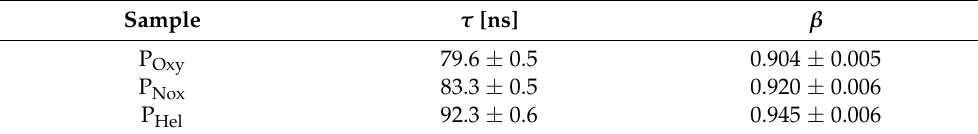
Figure 4. PL decay curve recorded on P Nox at 450 nm wavelength, under excitation at 320 nm and its corresponding curve fitting analysis using Equation (1). Table 2. Parameters obtained from decay curve fitting using Equation (1).